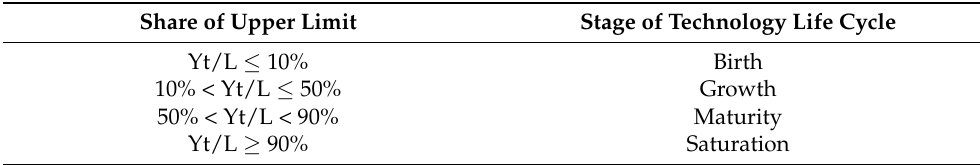
Table 3. Stage of technology life cycle by share of upper limit (authors’ elaboration from Ranaei et al.